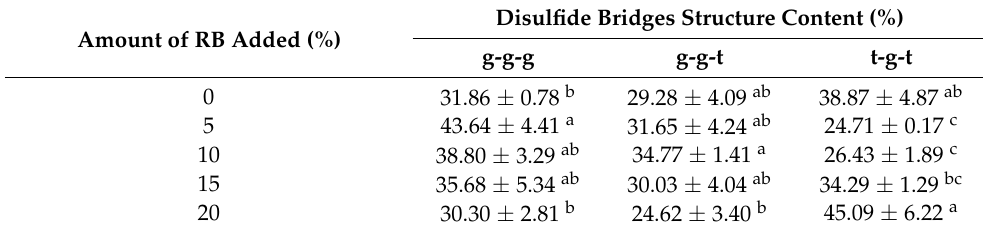
Table 4. Changes of disulfide bridges configuration in RB-SPI plant-based simulated